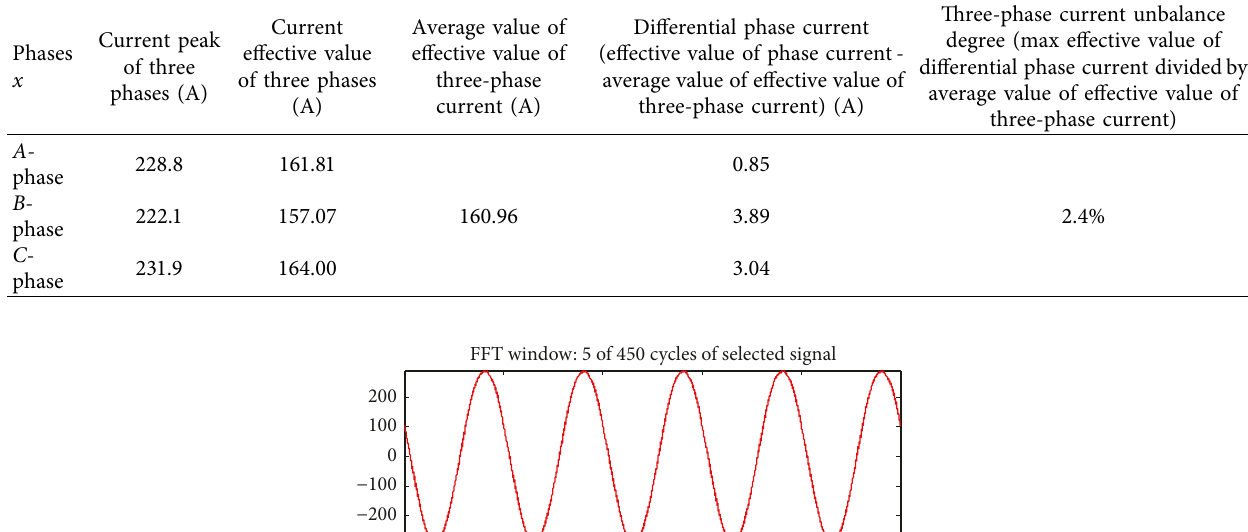
Table 3: Unbalance degree parameters of three phases.